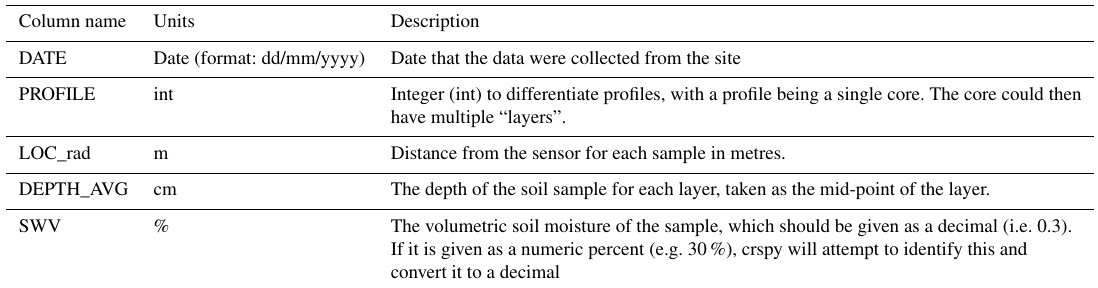
Table A2. The naming convention for the calibration data. This format should be followed and will allow the calibration module to be